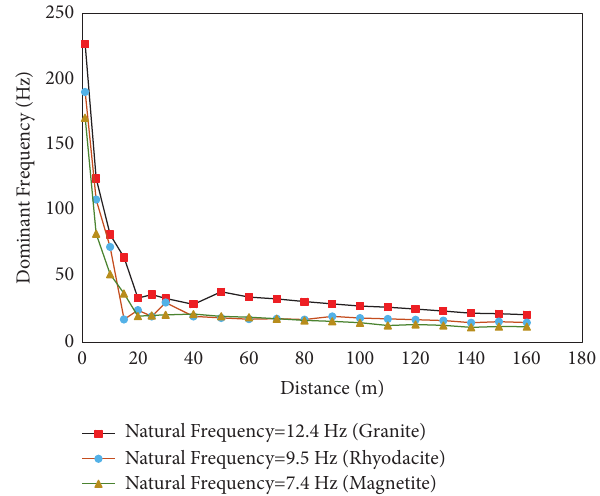
Figure 15: Dominant frequency diagram versus distance for dif- ferent natural